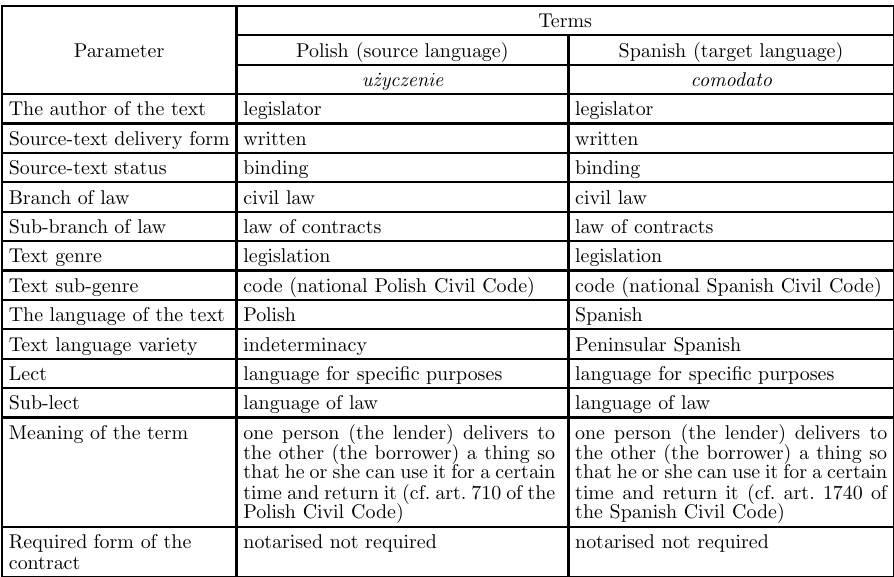
Parametric characterisation of the Polish term